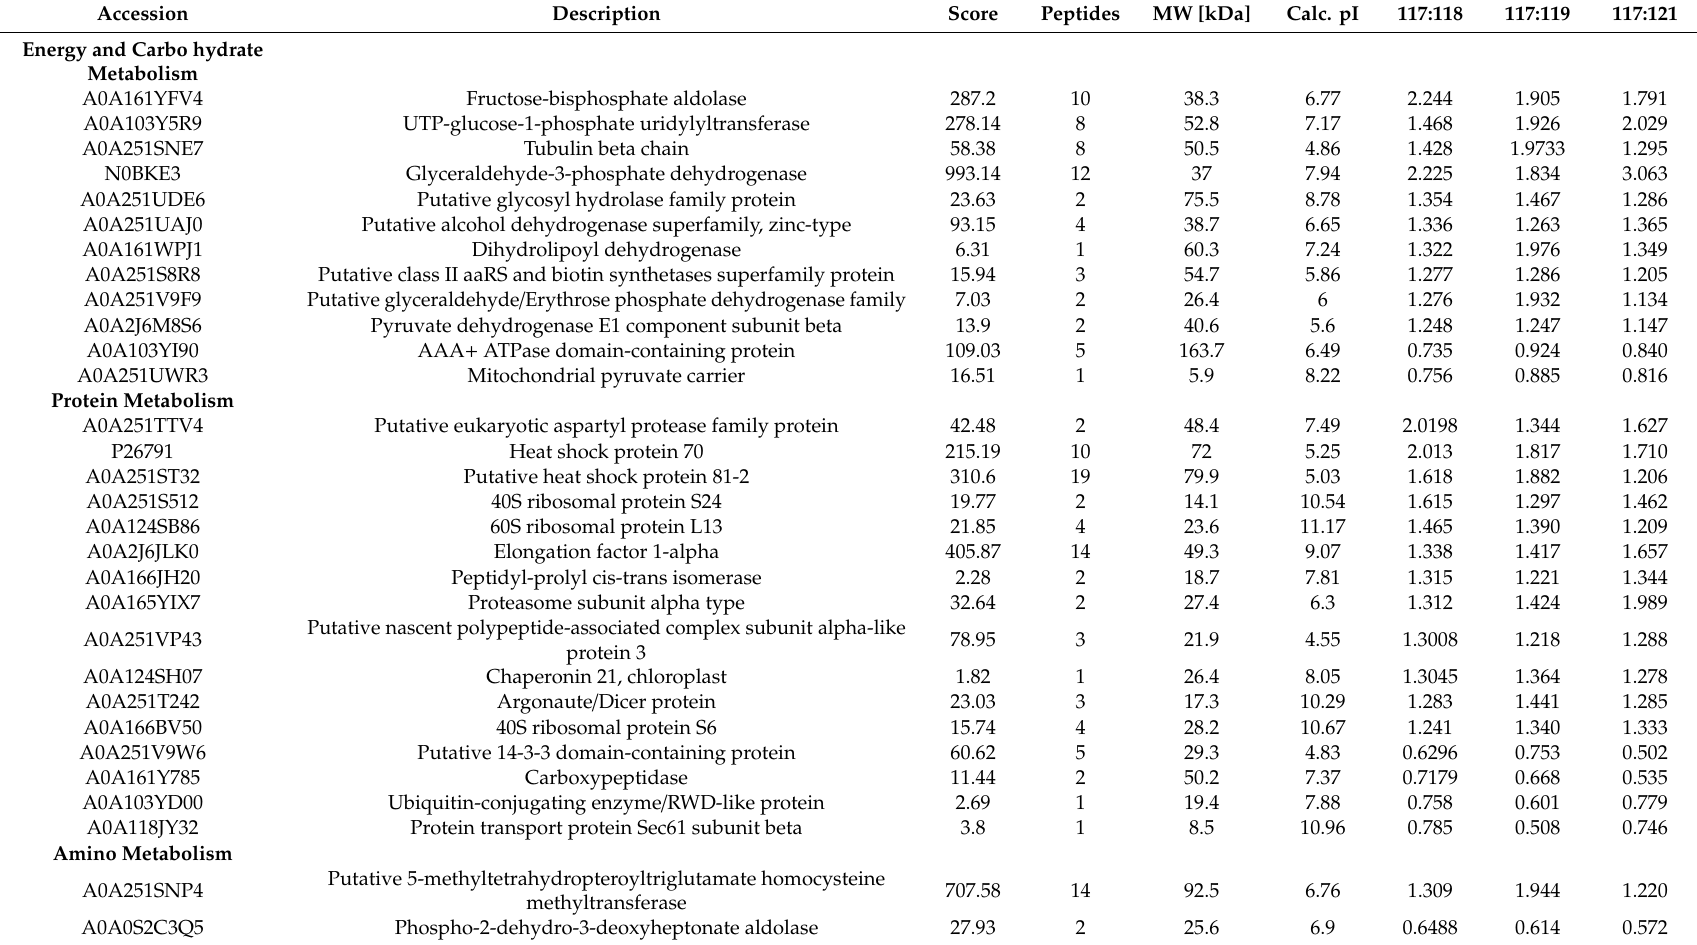
Table 2. Significantly di ff erentially expressed proteins in D. asperoides root proteins from di ff erent producing